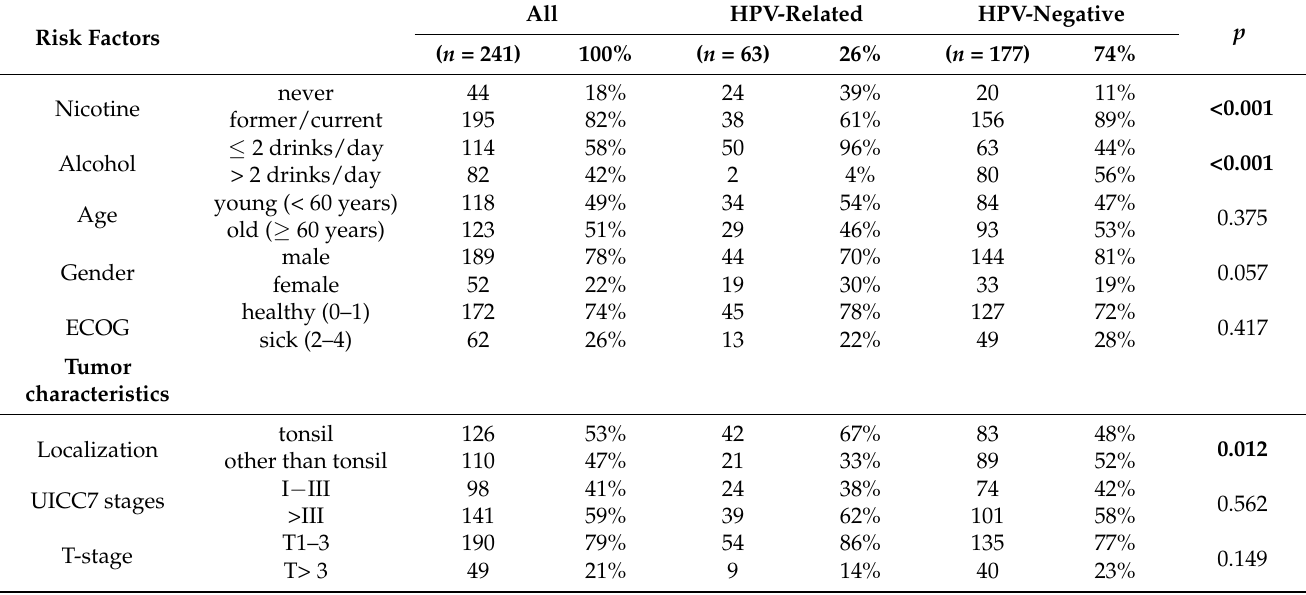
Table 1. Clinicopathological features of the OPSCC (oropharyngeal squamous cell carcinoma) patient cohort ( n = 241 *). Risk